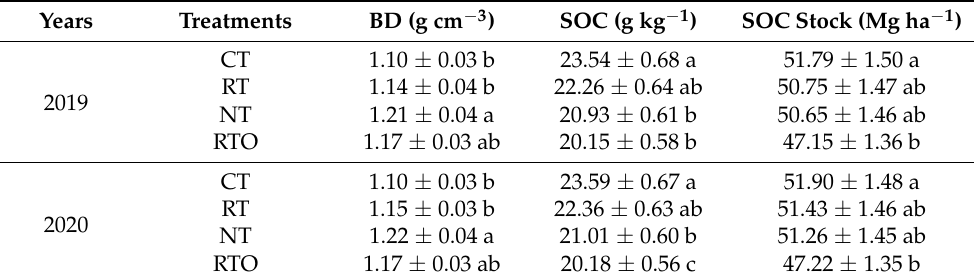
Table 1. Impacts of different short-term tillage managements on soil BD, SOC, and its stock of paddy field under the double-cropping rice system (0–20